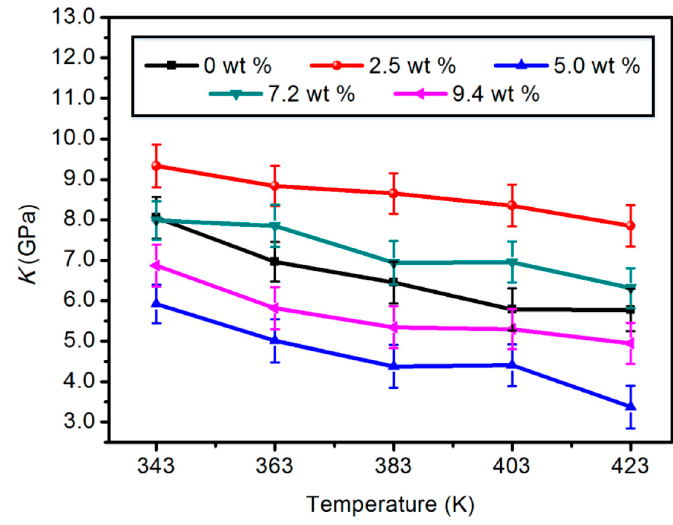
Figure 4. Bulk modulus of five different content composite models.